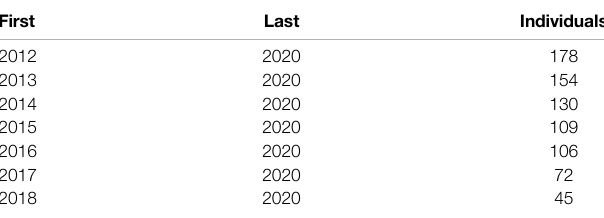
TABLE 3| Descriptionofdifferentvalidationsetsused incross-validation.The fi rst and last years of birth of animals in the training data set and the number of animals (individuals) used in the validation cohort are reported.